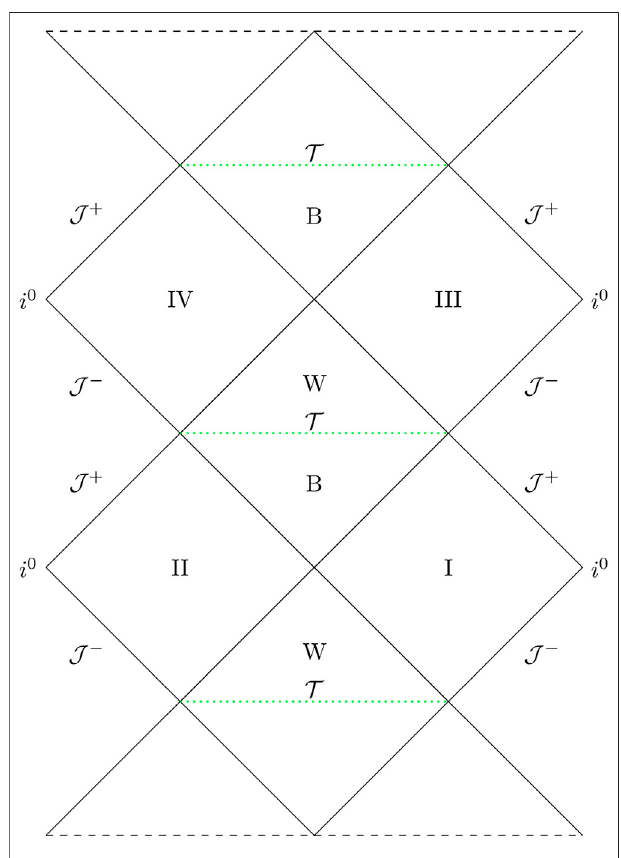
FIGURE 1 | Penrose diagram of the effective geometry determined by the slicing in Eq. 3.1 . Black and green lines indicate low and high curvature regions,respectively.Continuouslines represent smoothregionswhiledotted lines are associated to a discrete geometry. Dashed lines indicate that the spacetime diagram continues up and